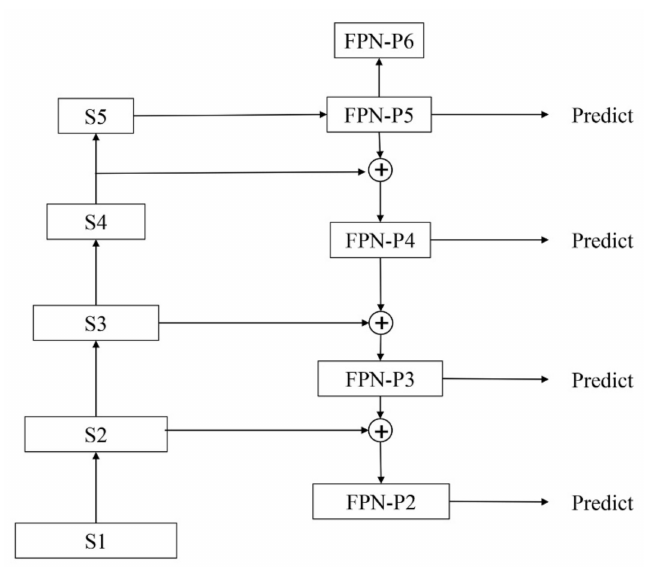
Figure 6. Data flow between MobileNets and the feature pyramid network (FPN).